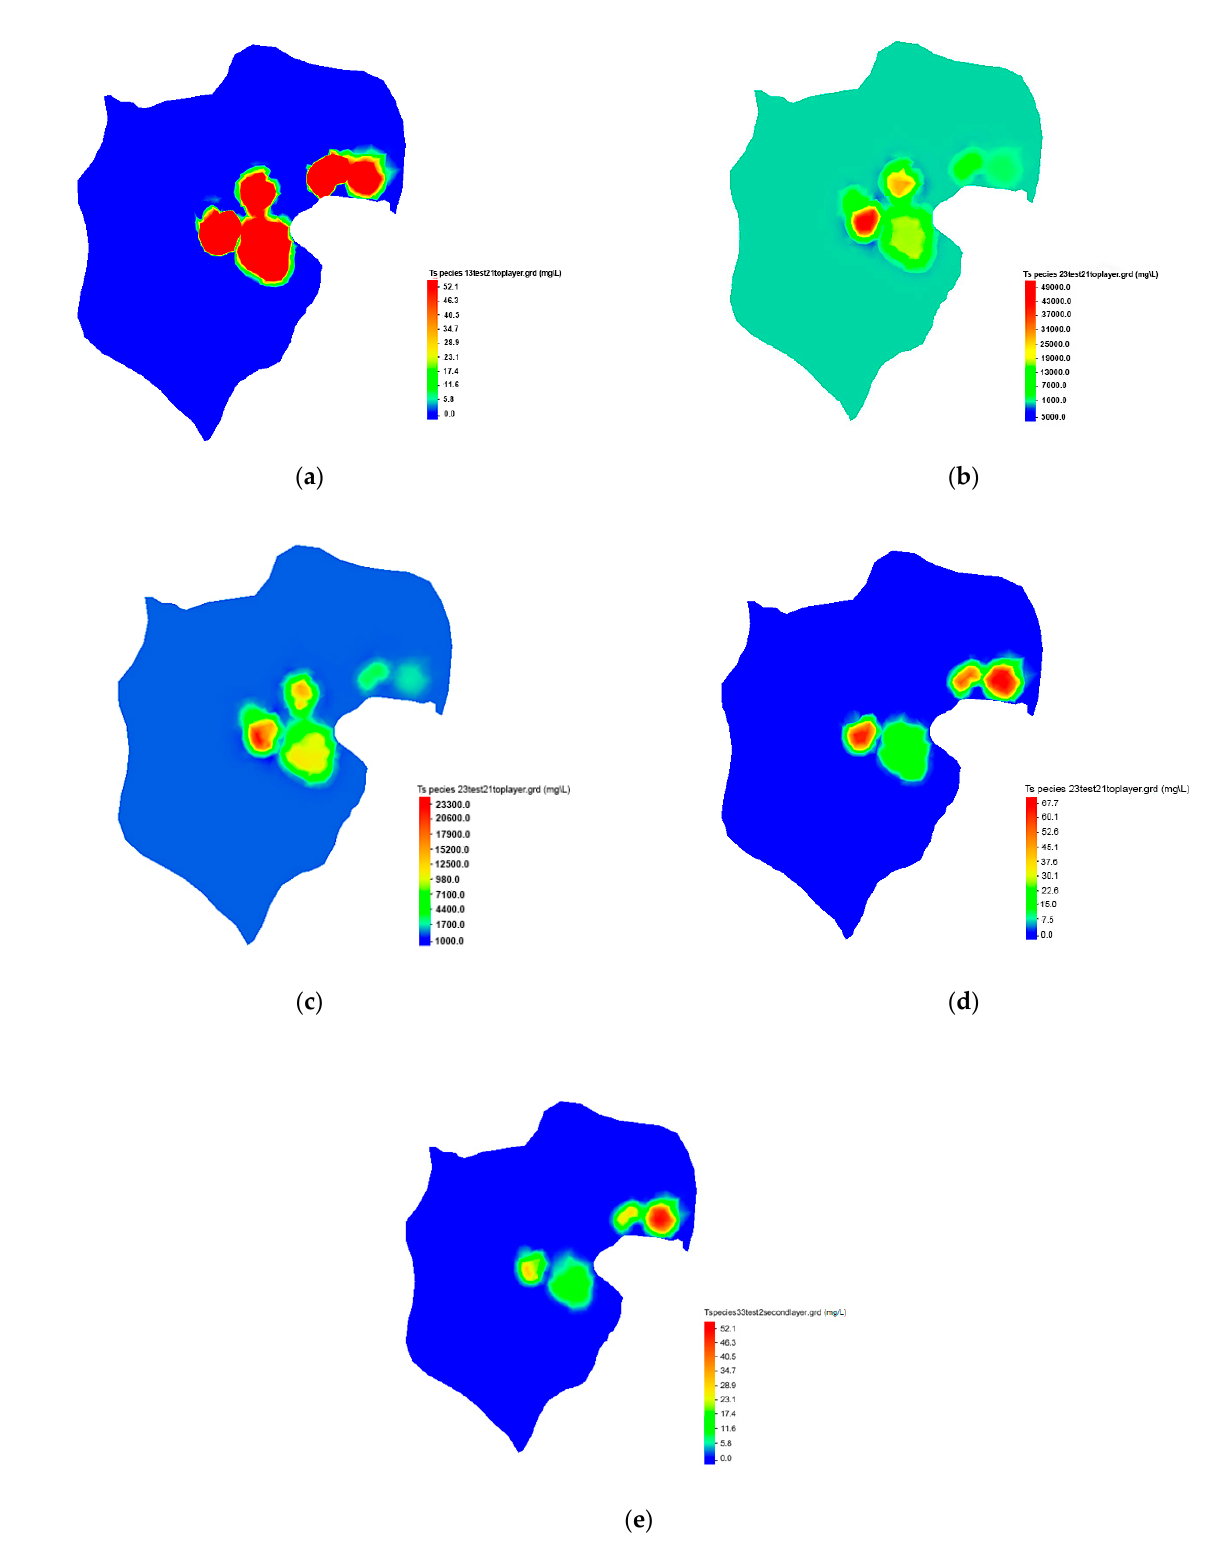
Figure 9. ( a ) Concentration plumes resulting from characterized sources for Species 1: Cu Layer 1. ( b ) Concentration plumes resulting from characterized sources for Species 2: SO 4 Layer 1. ( c ) Concentration plumes resulting from characterized sources for Species 2: SO 4 Layer 2. ( d ) Concentration plumes resulting from characterized sources for Species 3: UO 2 Layer 1. ( e ) Concentration plumes resulting from characterized sources for Species 3: UO 2 Layer